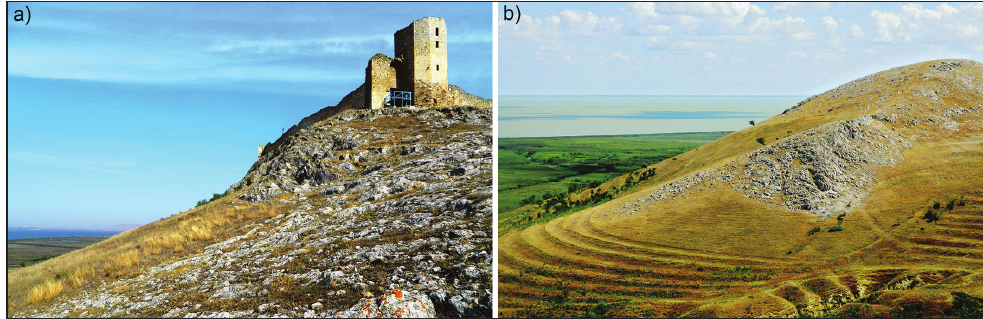
Figure 5. Collecting site of Scopula orientalis in Romania. a. Rocky steppe slopes at Enisala fortress, Tulcea county (photo taken on 30.ix.2017). b. The dry slopes around Enisala fortress, were S. orientalis was collect- ed, are bordered by vast wetland areas, which are partly visible on the left side of the image (photo taken on 26.viii.2016). Photos: L.